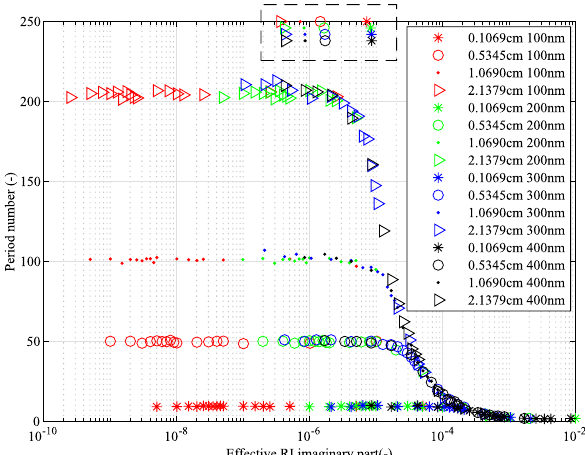
Figure 6. Period number with volume ratio ratios for different sizes of NPs (100 nm in red, 200 nm in green, 300 nm in blue and 400 nm in black) with different gauge lengths (0.1069 cm with star, 0.5345 cm with circle, 1.0690 cm with triangle and 2.1379 cm with point). The patterns in the dash rectangular frame are only used show the maximum values of the imaginary part of effective RI based on the single scattering restriction.